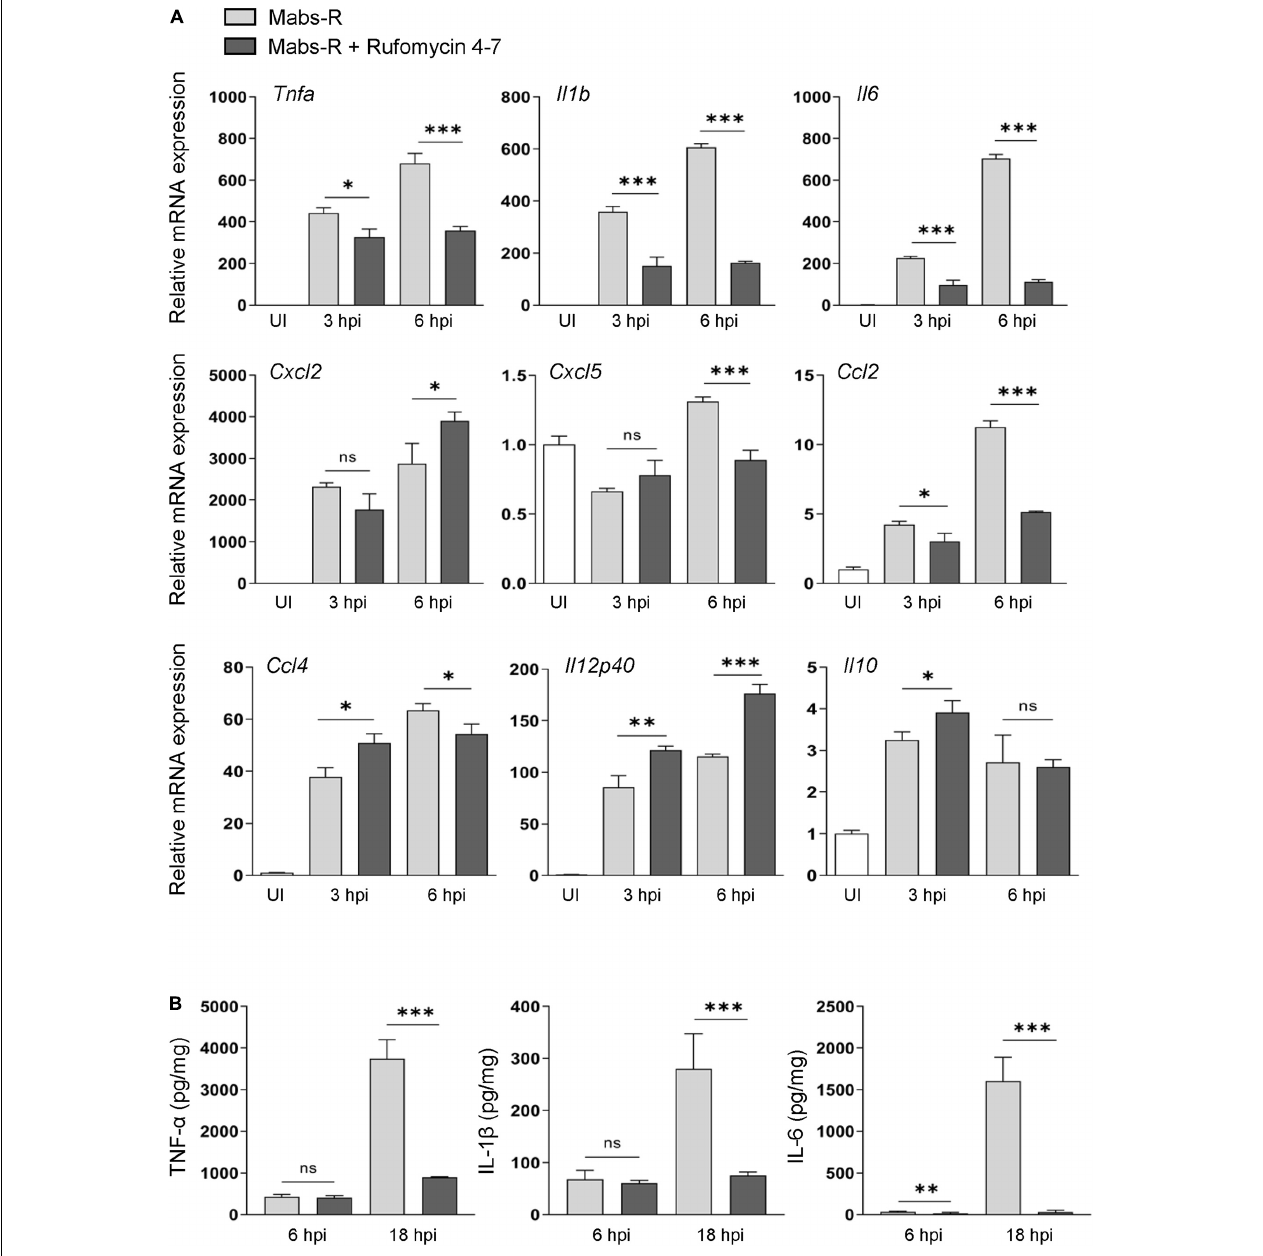
FIGURE 2 | Rufomycin 4–7 regulates the expression of inflammatory cytokines during Mabs-R infection. (A) BMDMs were infected with Mabs-R (MOI = 3) for 2 h and then incubated with sc or Rufomycin 4–7 (10 µ M) in the freshly changed media. The cells were harvested at the indicated times and subjected to qRT-PCR analysis to measure the expression of inflammatory cytokine/chemokine genes. (B) The supernatants from the BMDMs prepared as in (A) were collected at 6 and 18 hpi and subjected to ELISA to measure the cytokine level of TNF- α , IL-1 β , and IL-6. ∗ p < 0.05, ∗∗ p < 0.01, and ∗∗∗ p < 0.001. Statistical analysis was determined with unpaired t -test and presented as means ± SD from at least three independent experiments performed in triplicate. ns, not significant; UI, uninfected; hpi, hours post-infection.